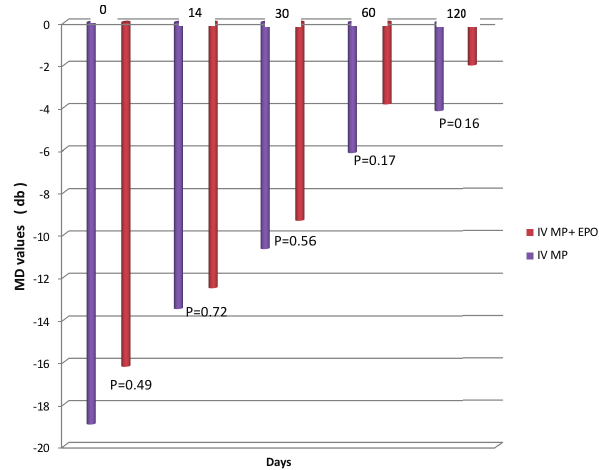
Figure 3. Mean deviation (MD) in patients with retrobulbar optic neuritis in the two treatment groups. IV MP, intravenous methylprednisolone; IV MP + EPO, intravenous methylpred- nisolone in combination with intravenous